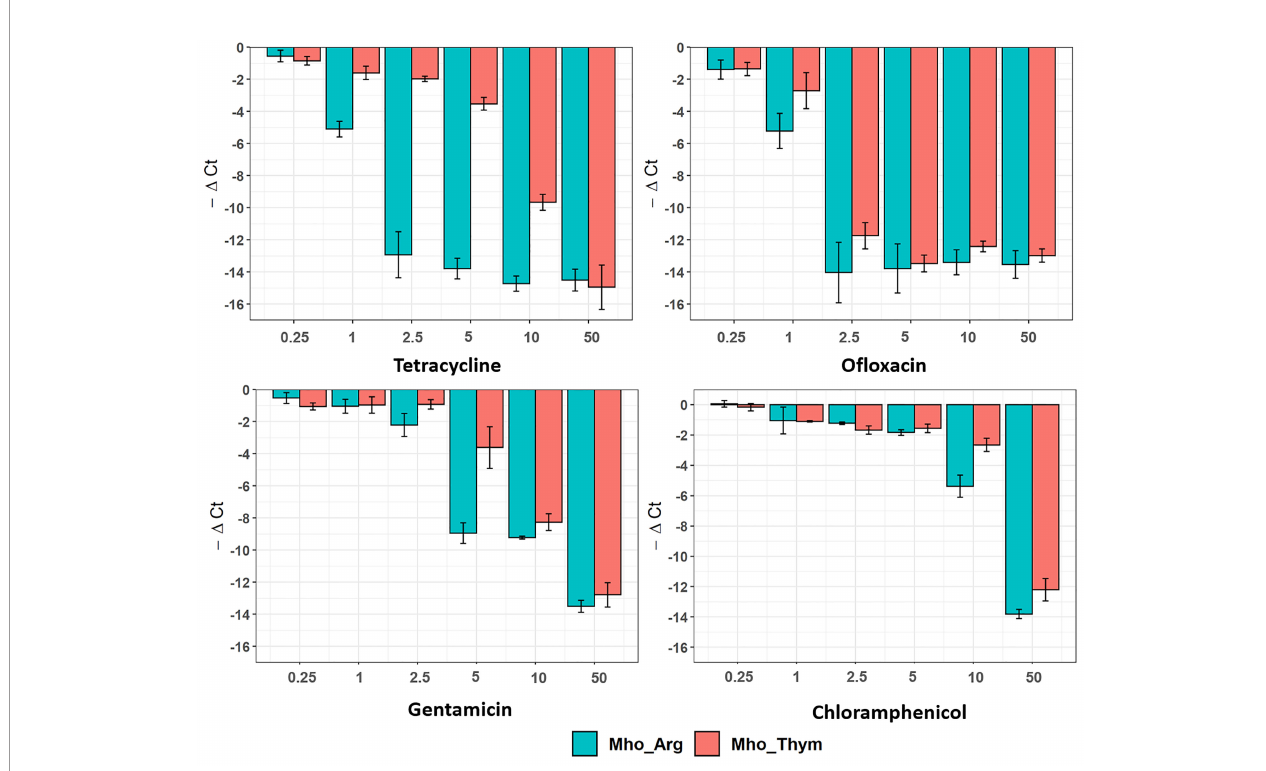
FIGURE 2 | Susceptibility of M. hominis to antibiotics. M. hominis was cultivated on an arginine or thymidine-supplemented medium with different antibiotic concentration range: 0.25, 1, 2.5, 5, 10 and 50 m g/mL. Differences between Cq-values for antibiotic treatment samples and positive control samples without treatment are shown. All bar-plots are averages of triplicate experiments with standard deviation error